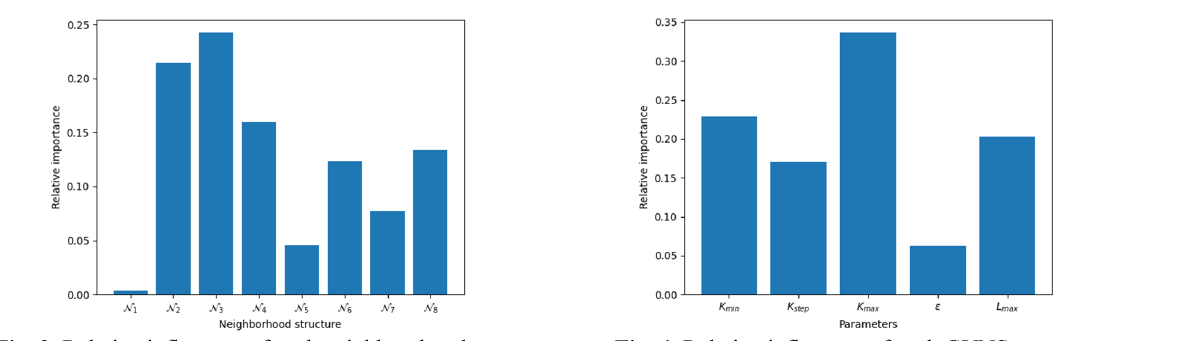
Fig. 3. Relative influences of each neighbourhood structure Fig. 4. Relative influences of each GVNS